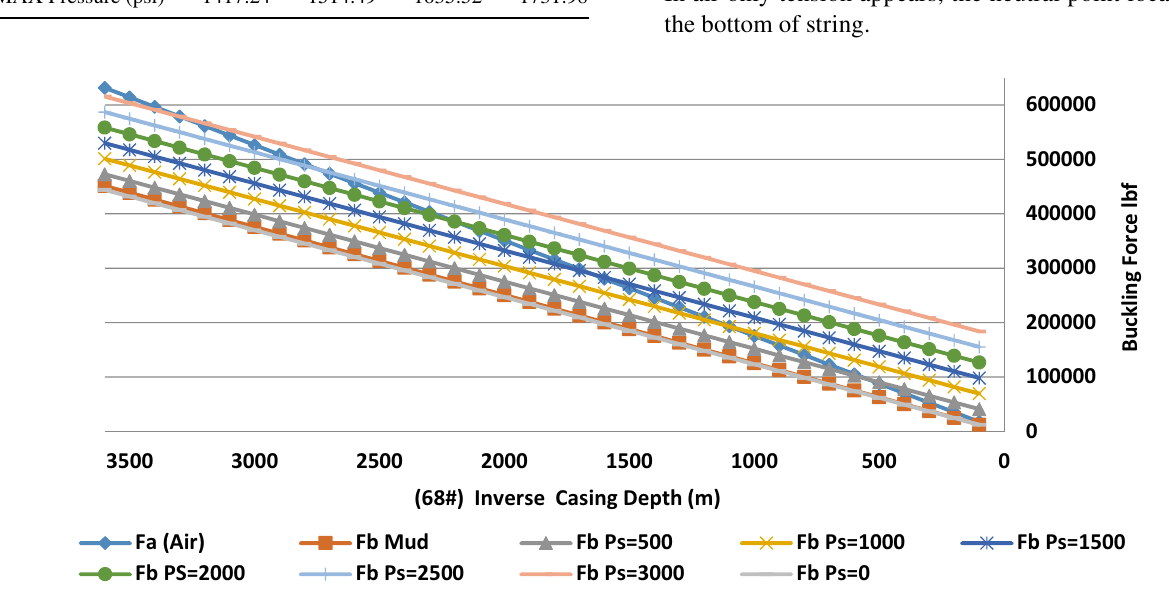
Fig. 9 Variation of additional buckling force compared to casing depth (13 ″ 3/8 (68#) casing)